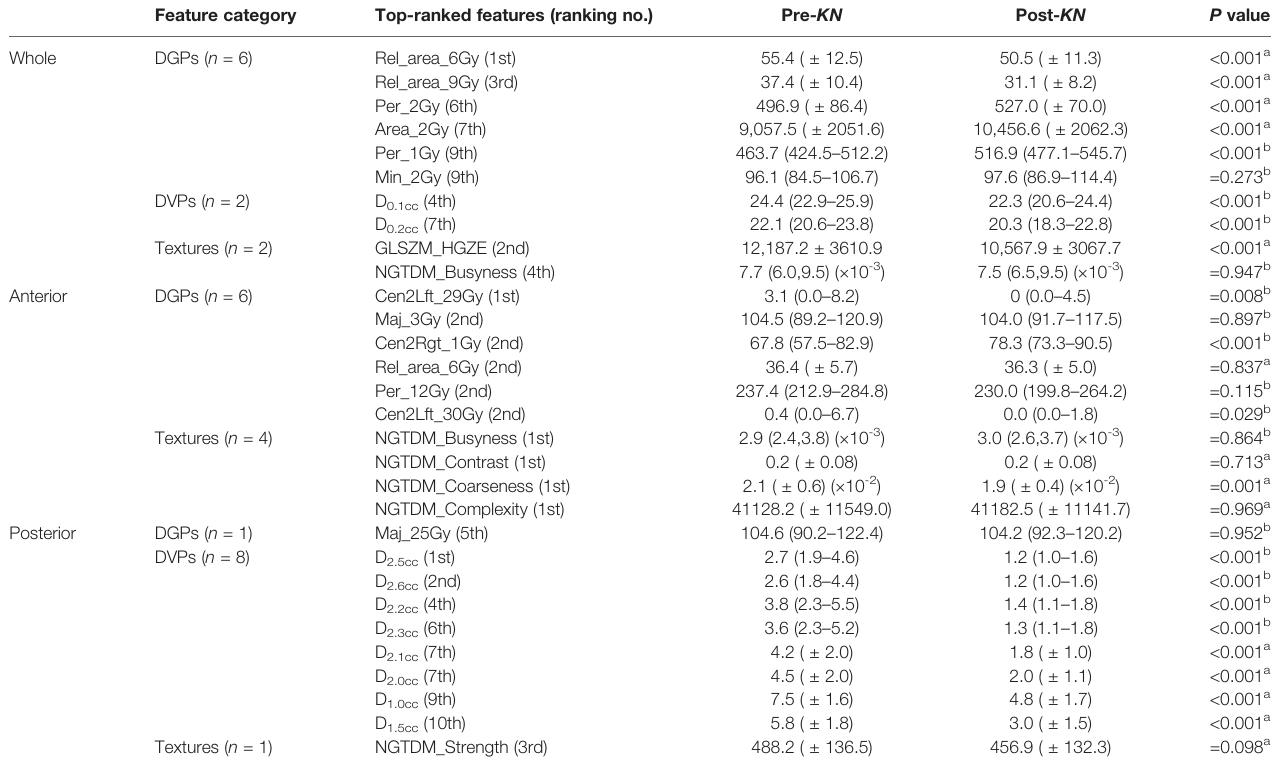
TABLE 4 | Top 10 most frequently selected features. Feature category Top-ranked features (ranking no.)